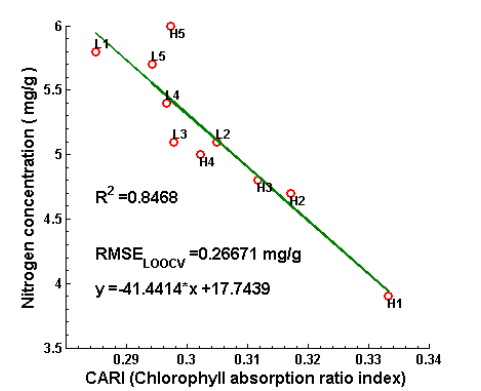
Figure 3 Regression plot between the laboratory analysed nitrogen concentration (mg/g) and the Chlorophyll Absorption Ratio Index (CARI).